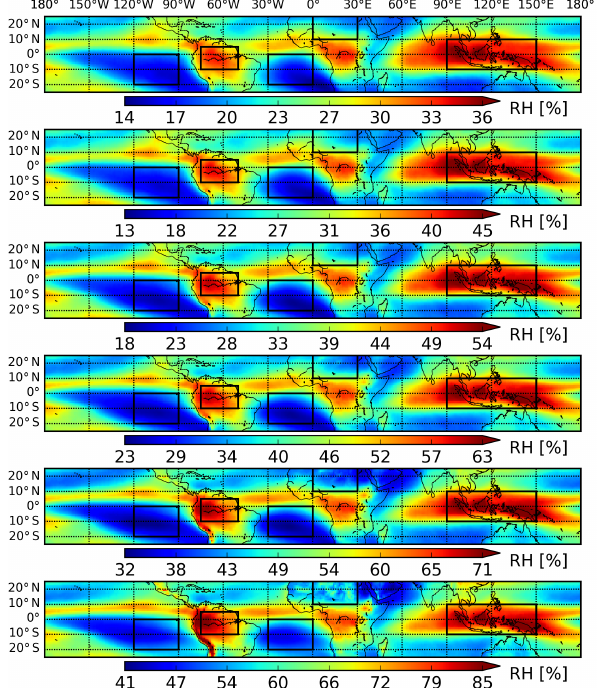
Figure 7. Spatial distribution of layer-averaged RH I derived using SAPHIR data for the period January 2012 to September 2015. De- picts from top to bottom are for SAPHIR channels 1–6,